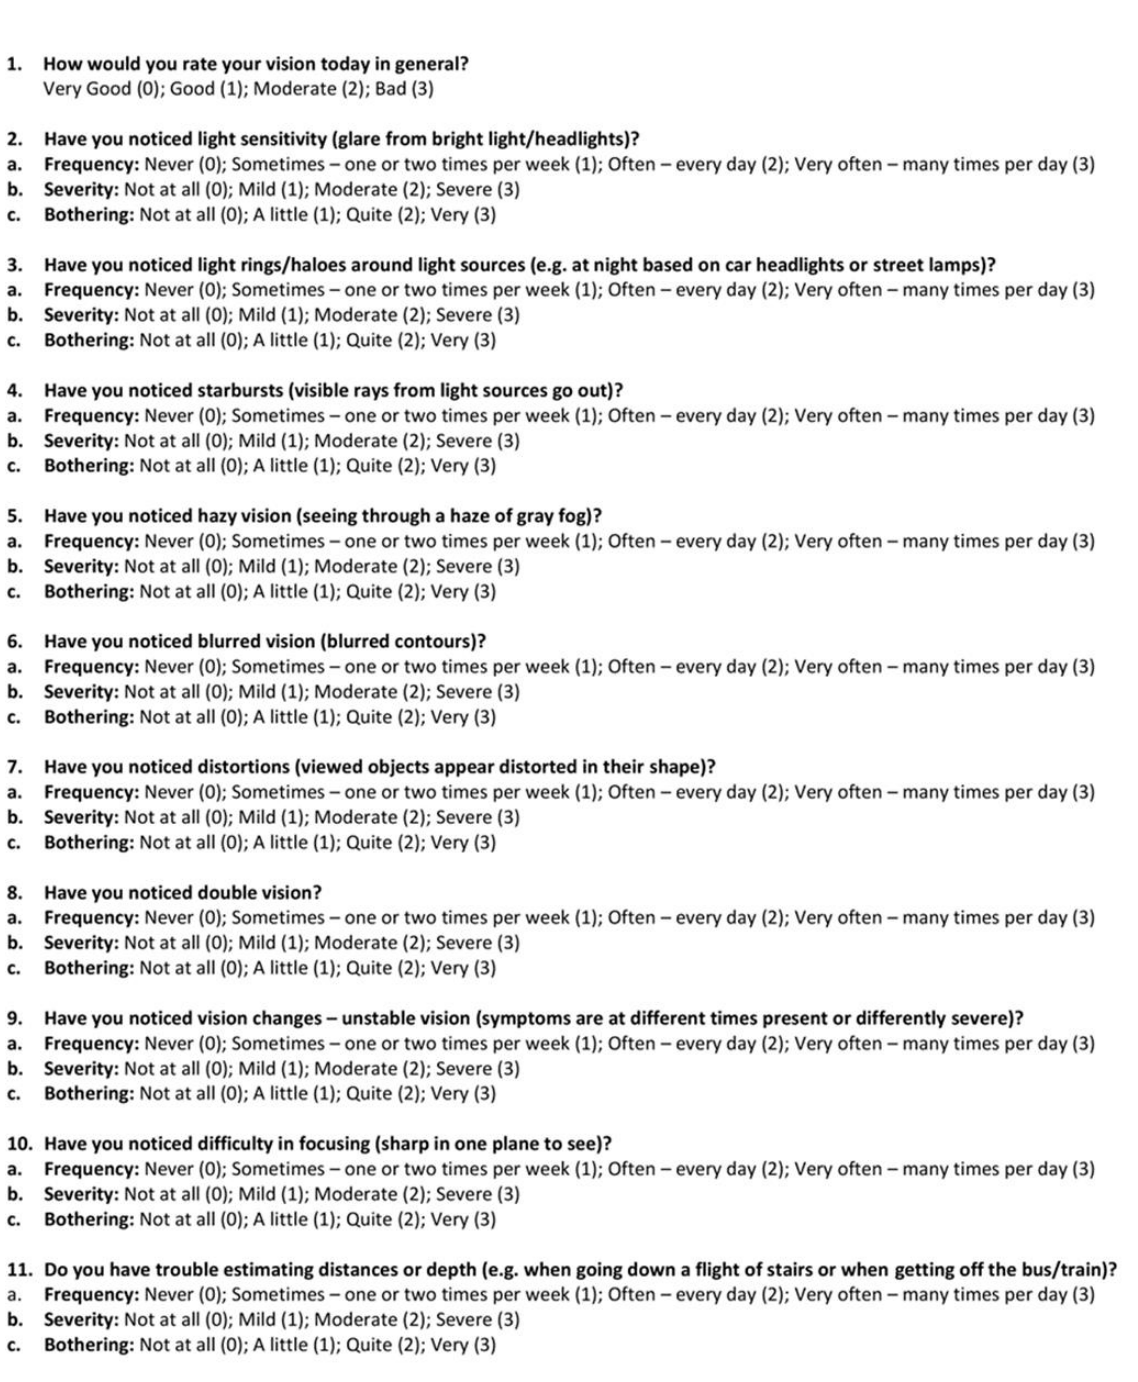
Figure 1. Questionnaire of visual quality. The primary question targeted the perception of the overall visual quality. The following 10 questions addressed visual disturbances that are common in patients receiving atropine eye drops: light sensitivity, haloes, starbursts, hazy vision, blurred vision, distortion, double vision, unstable vision, difficulty in focusing, and difficulty in estimating distances or depth. Each of these 10 questions was answered in relevance to frequency, severity, and bothersomeness. Participants answered each question on a scale from 0 (least frequent, severe, or bothersome) to 3 (most frequent, severe, or bothersome).